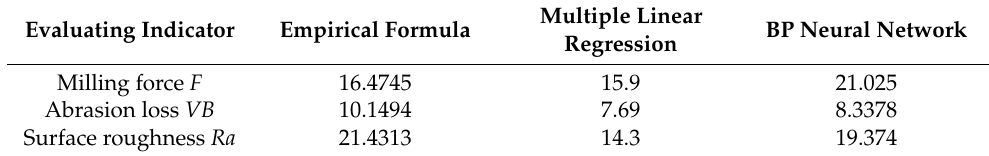
Table 8. Root mean square error